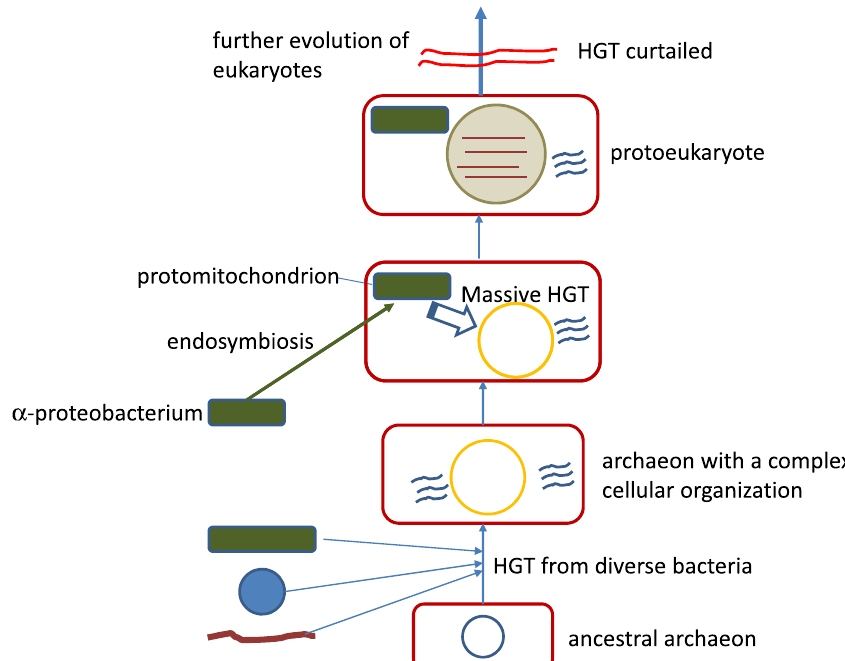
Figure 2. Eukaryogenesis and horizontal gene transfer. The figure presents the ‘endosymbiotic’ model of eukaryogenesis under which the host of the protomitochondrial endosymbiont was a typical archaeon albeit one with a relatively complex intracellular organization and numerous genes captured from bacteria via HGT. Abbreviations: HGT, horizontal gene